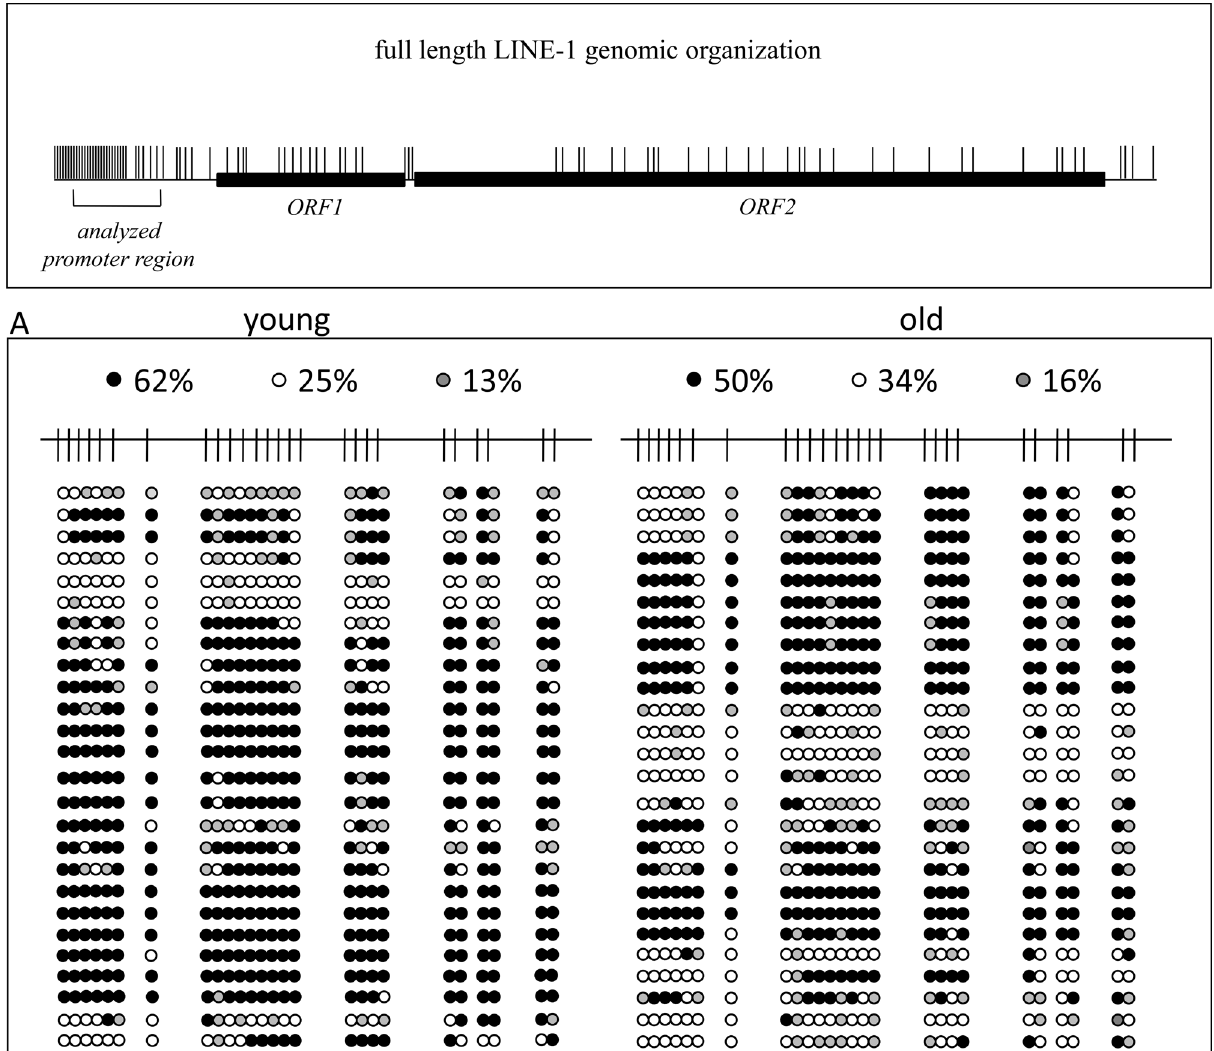
Figure 3. Detailed analysis of LINE-1 promoter CpG-methylation derived from peripheral blood cellular DNA ( A ) and cell-free DNA ( B ) of 8 young individuals aged 21–29 years (left panels) and 8 elder individuals aged 50–58 years (right panels). On top, a schematic representation of a full-length LINE-1 retroelement is given showing the distribution of CpG dinucleotides (short vertical lines) and the open reading frames 1 and 2 (ORF1/2). The analyzed 436 bp region of interest is indicated by square brackets. Detailed CpG-methylation profiles of this region revealed by bisulfite genomic sequencing are shown in panels A and B. Filled circles stand for methylated CpG dinucleotides. White circles stand for unmethylated CpGs. Grey circles stand for an undefined CpG methylation status. In the panel C the result is illustrated in bar diagrams in order to visualize the most differentially methylated CpG positions. Each bar shows the frequency of methylated CpGs at the position indicated. Positions are relative to the ATG start codon of LINE-1 ORF1. An asterisk indicates the positions of the primers used for the MS-PCR shown in Fig. 1. The left diagram shows the analyses from peripheral blood cellular DNA of young (green) and elder (blue) individuals. The right diagram shows the analyses from peripheral blood cfDNA of young (green) and elder (blue)